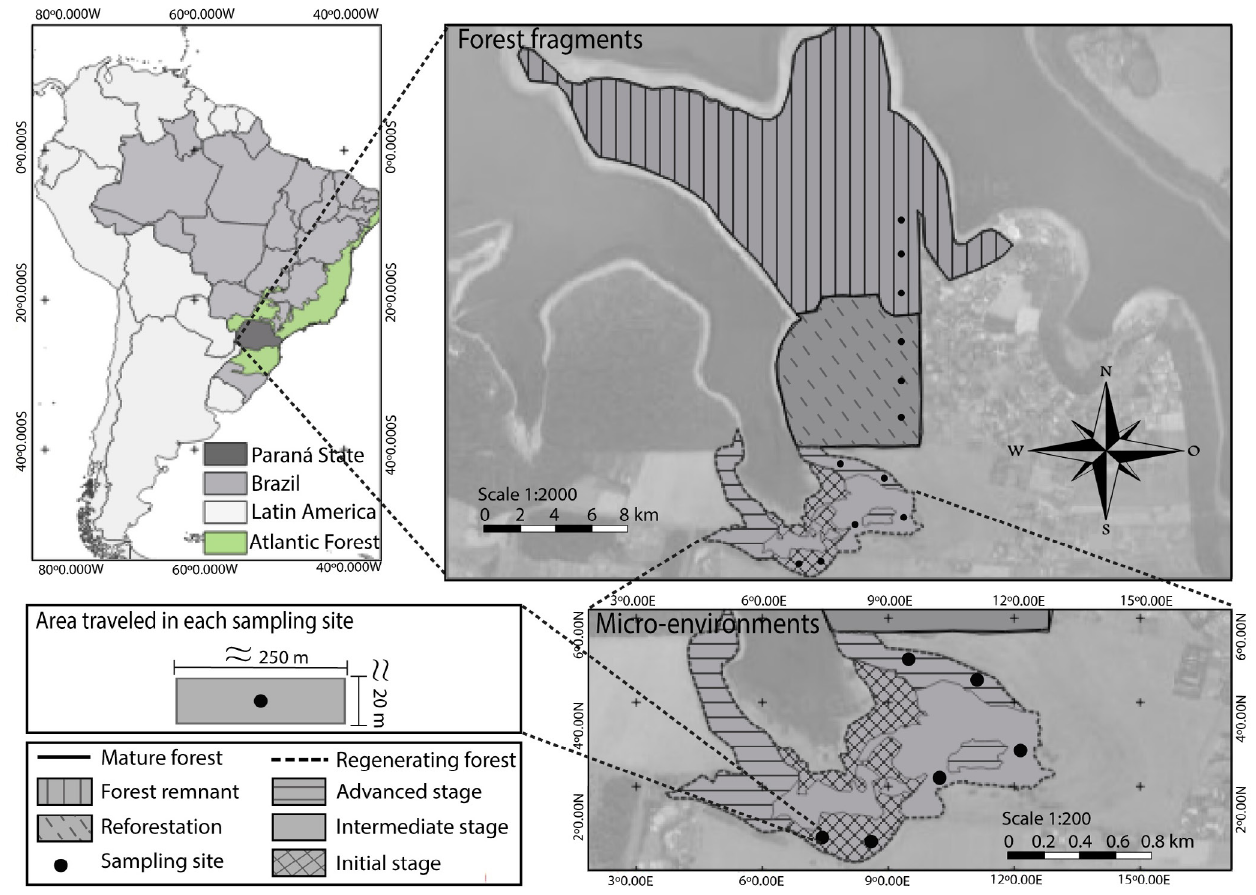
Fig 1 . Location and composition of the two forest fragments and the twelve sites used in the bee sampling of the Atlantic Forest, Paraná, southern Brazil. Illustration of the mosaic of micro-environments and area traversed at each sampling site (see Table 1 –